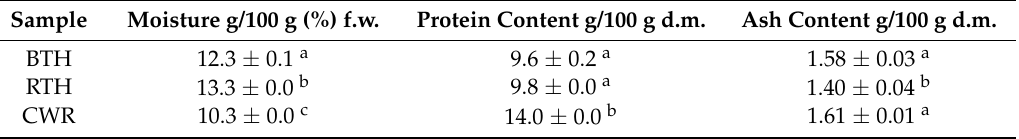
Table 1. Proximate composition of colored Thai and wild